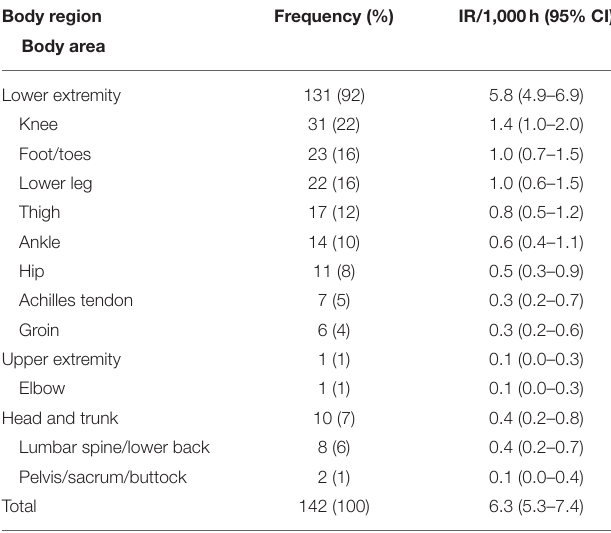
TABLE 2 | Self-reported RRIs and pains or discomfort by body region and